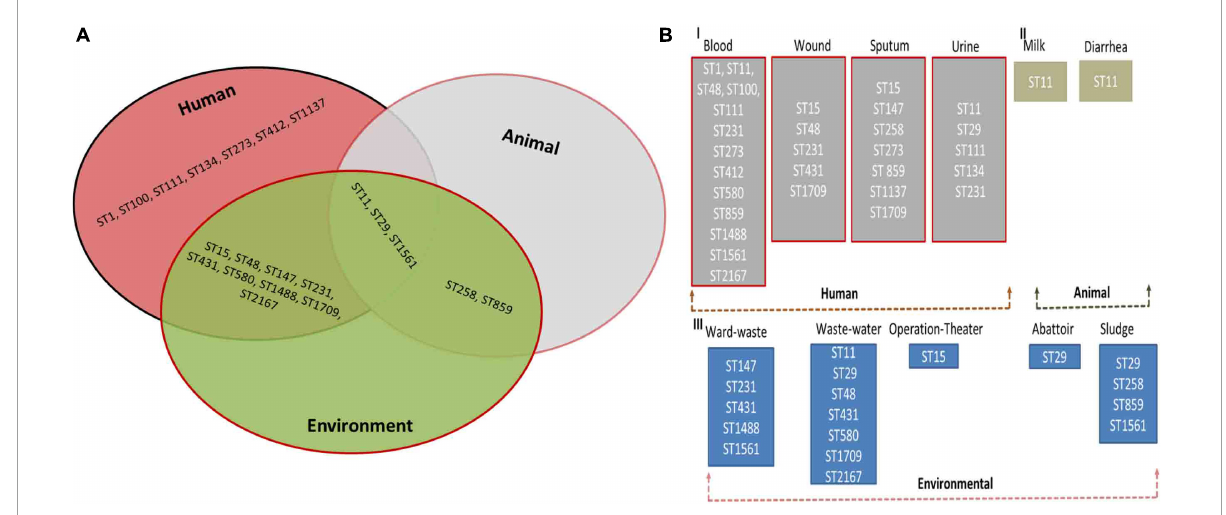
FIGURE2 (A) Distribution of multilocus sequence types (STs) of Klebsiella pneumoniae in Human, Animal, and Environment. (B) Prevalence of multilocus sequence types (STs) in blood, wound, sputum, urine (Human) (I) , milk and fecal (Animal) (II) and ward-waste, wastewater, operation-theater, Abattoir, and sludge (Environment) (III)